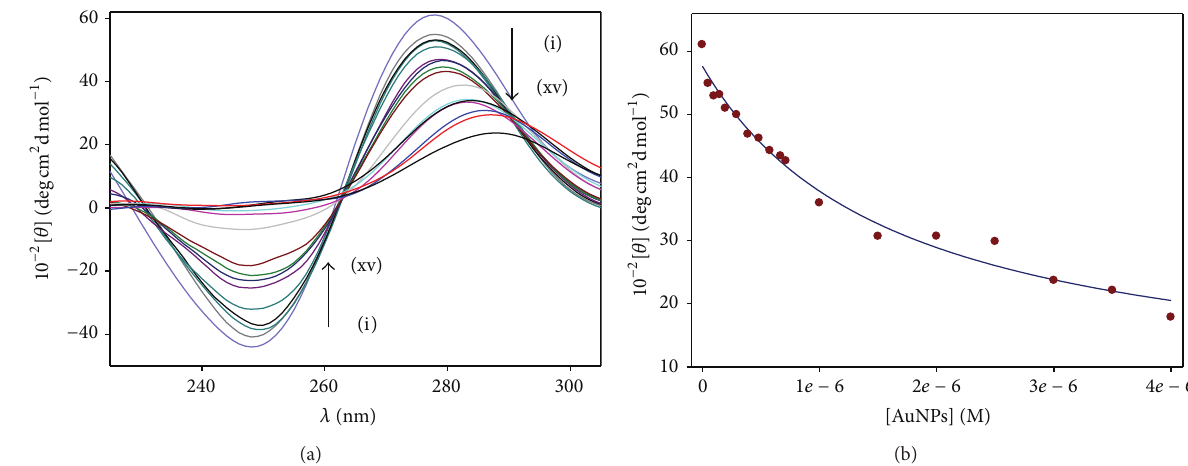
Figure 3: (a) CD titration of AuNPs with DNA in water. [DNA] = 1 × 10 −4 M. Curves from (i) to (xv) correspond to 0, 0.15, 0.29, 0.39, 0.58, 0.71, 1.00, 1.50, 2.00, and 4.00 𝜇 M of AuNPs. (b) Plot of the molar ellipticity experimental data versus AuNPs concentrations. Symbols ( ∙ ) are experimental data and line is the best fit using (2).